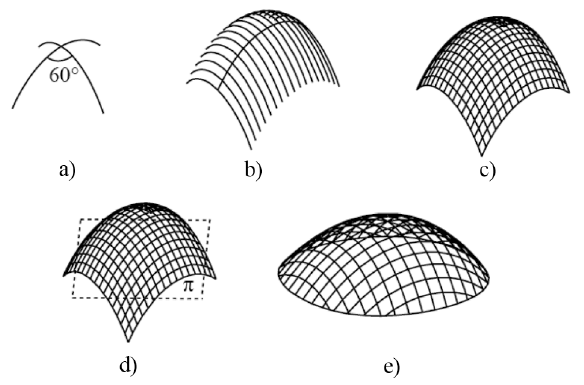
Fig. 2. Generation of the surface